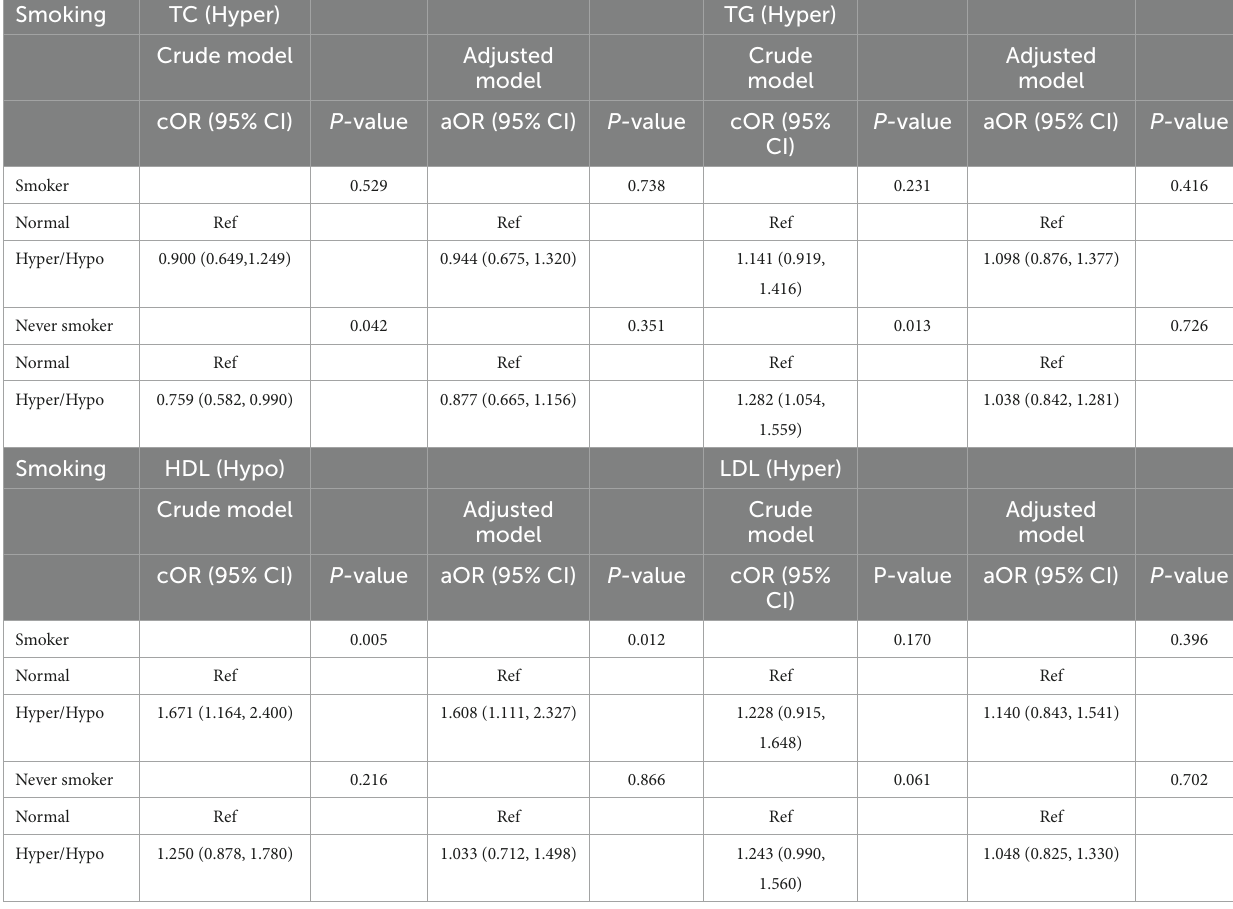
TABLE 7 Odds ratios for associations between triglyceride and cholesterol levels and anti-HBs results stratified by smoking